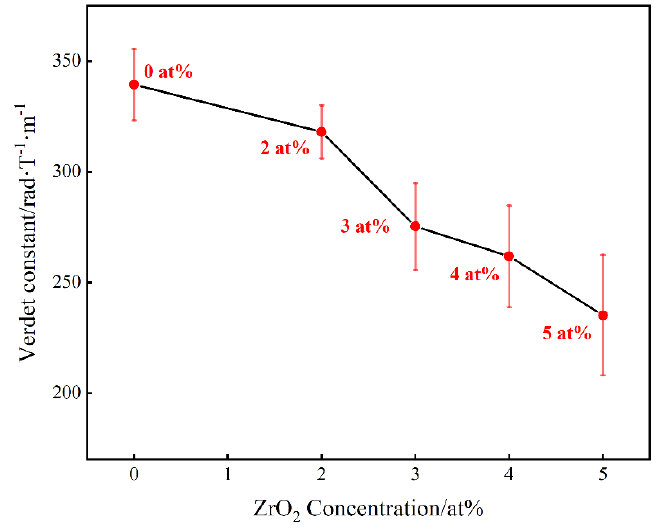
Figure 8. Verdet constant of Zr: (Tb 0.7 Lu 0.3 ) 2 O 3 ceramics versus Zr 4+ concentration at the 650 nm wavelength at room temperature.